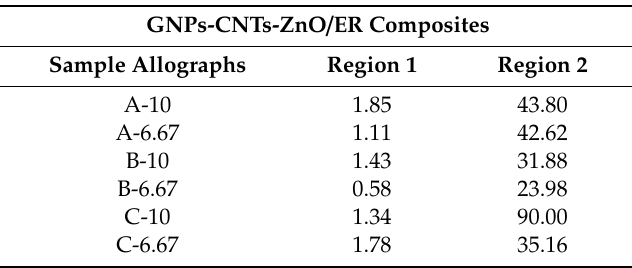
Table 2. Average nonlinear coe ffi cients values of GNPs-CNTs-ZnO / ER samples of six di ff erent samples.